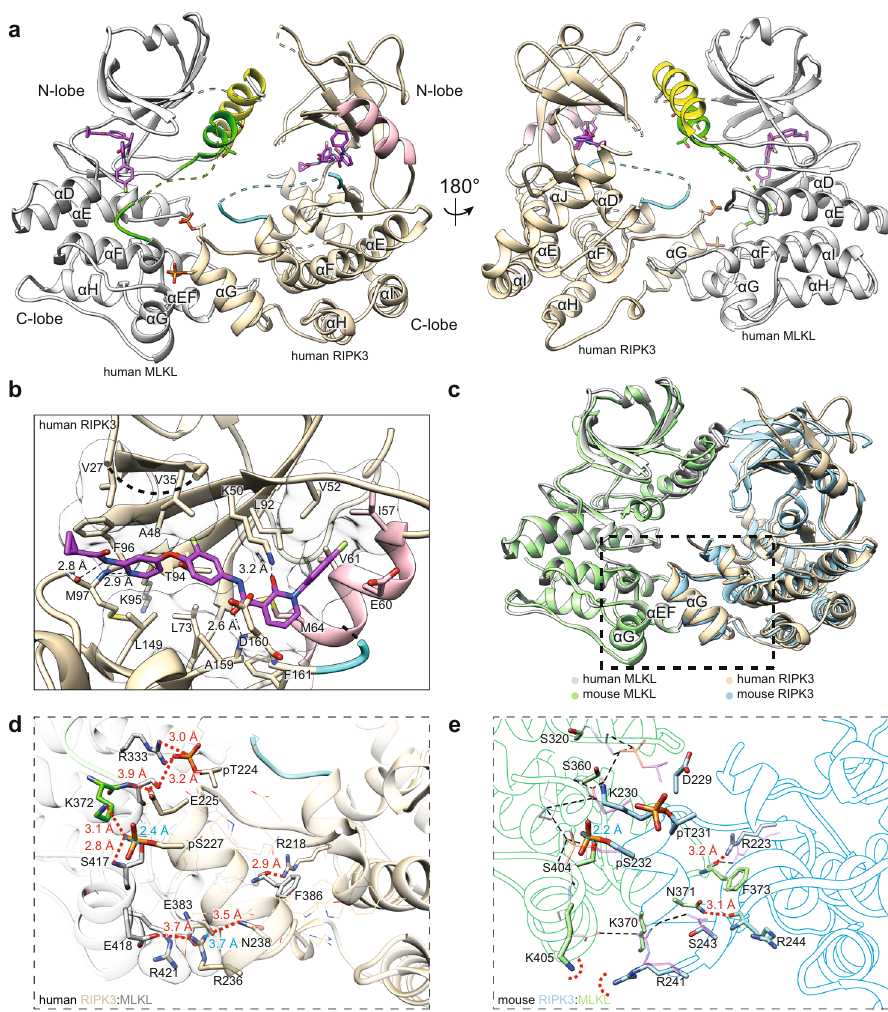
Fig. 1 The human MLKL pseudokinase domain and RIPK3 kinase domain form a face-to-face complex. a Orthogonal views of the co-crystal structure of human RIPK3 (residues 1 – 316; C3S, C110A):human MLKL (residues 190 – 471). MLKL (gray), α C helix (yellow), and activation loop (green) are highlighted. RIPK3 (wheat), α C helix (pink), and activation loop (cyan) are highlighted. Compound 10 (magenta) and key phosphorylation sites (RIPK3:pS227, pT224; MLKL:T357, S358), and F386 are shown as sticks. Dashed lines represent chain connectivity where insuf fi cient electron density was observed to allow model building. b Zoomed view of Compound 10 binding to the human RIPK3 active site. Sidechains and backbone atoms interacting with Compound 10 (magenta) are shown as sticks. Electrostatic interactions are shown as black dashed lines. Transparent surfaces are shown for residues that hydrophobically interact with Compound 10. c Overlay of human RIPK3 (gray):MLKL (wheat) (this study; PDB: 7MON) with the mouse RIPK3 (green):MLKL (blue) complex (PDB: 4M69) 46 . Alignment was performed by superimposing the respective MLKL in each complex model using UCSF Chimera Matchmaker. d Zoomed view of the C-lobe electrostatic and hydrophobic interactions within the human RIPK3:MLKL structure. Sidechains involved in electrostatic interactions are shown as sticks; sidechains mediating non-polar interactions are shown as thin lines. Electrostatic interactions are shown with red dashed lines or in blue when hidden behind sidechains. e Zoomed views of the C-lobe electrostatic interactions from the mouse RIPK3:MLKL structure. Peptide backbones are shown as silhouettes. Sidechains involved in electrostatic interactions are shown as sticks and labeled. Electrostatic interactions are shown with red dashed lines or in blue when hidden behind sidechains. Dashed red semi-circles illustrate the potential electrostatic repulsion between mouse MLKL K405 and RIPK3 R241. Electrostatic interactions from the human RIPK3:MLKL structure are overlaid (thin black dashed lines) with human residue sidechains shown as thin transparent